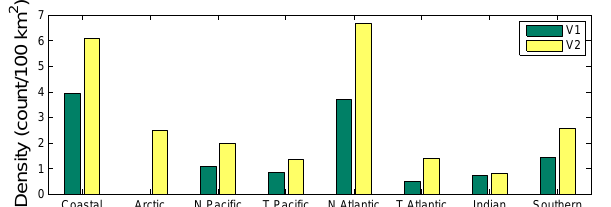
Figure 6. The density of surface water f CO 2 values for each re- gion in SOCAT versions 1 and 2. Regions are the Coastal Seas, the Arctic Ocean, the North Pacific Ocean, the Tropical Pacific Ocean, the North Atlantic Ocean, the Tropical Atlantic Ocean, the Indian Ocean and the Southern Ocean (Fig. 5, Table 5). In version 1, Arctic data were included in the North Pacific, North Atlantic and Coastal Regions.